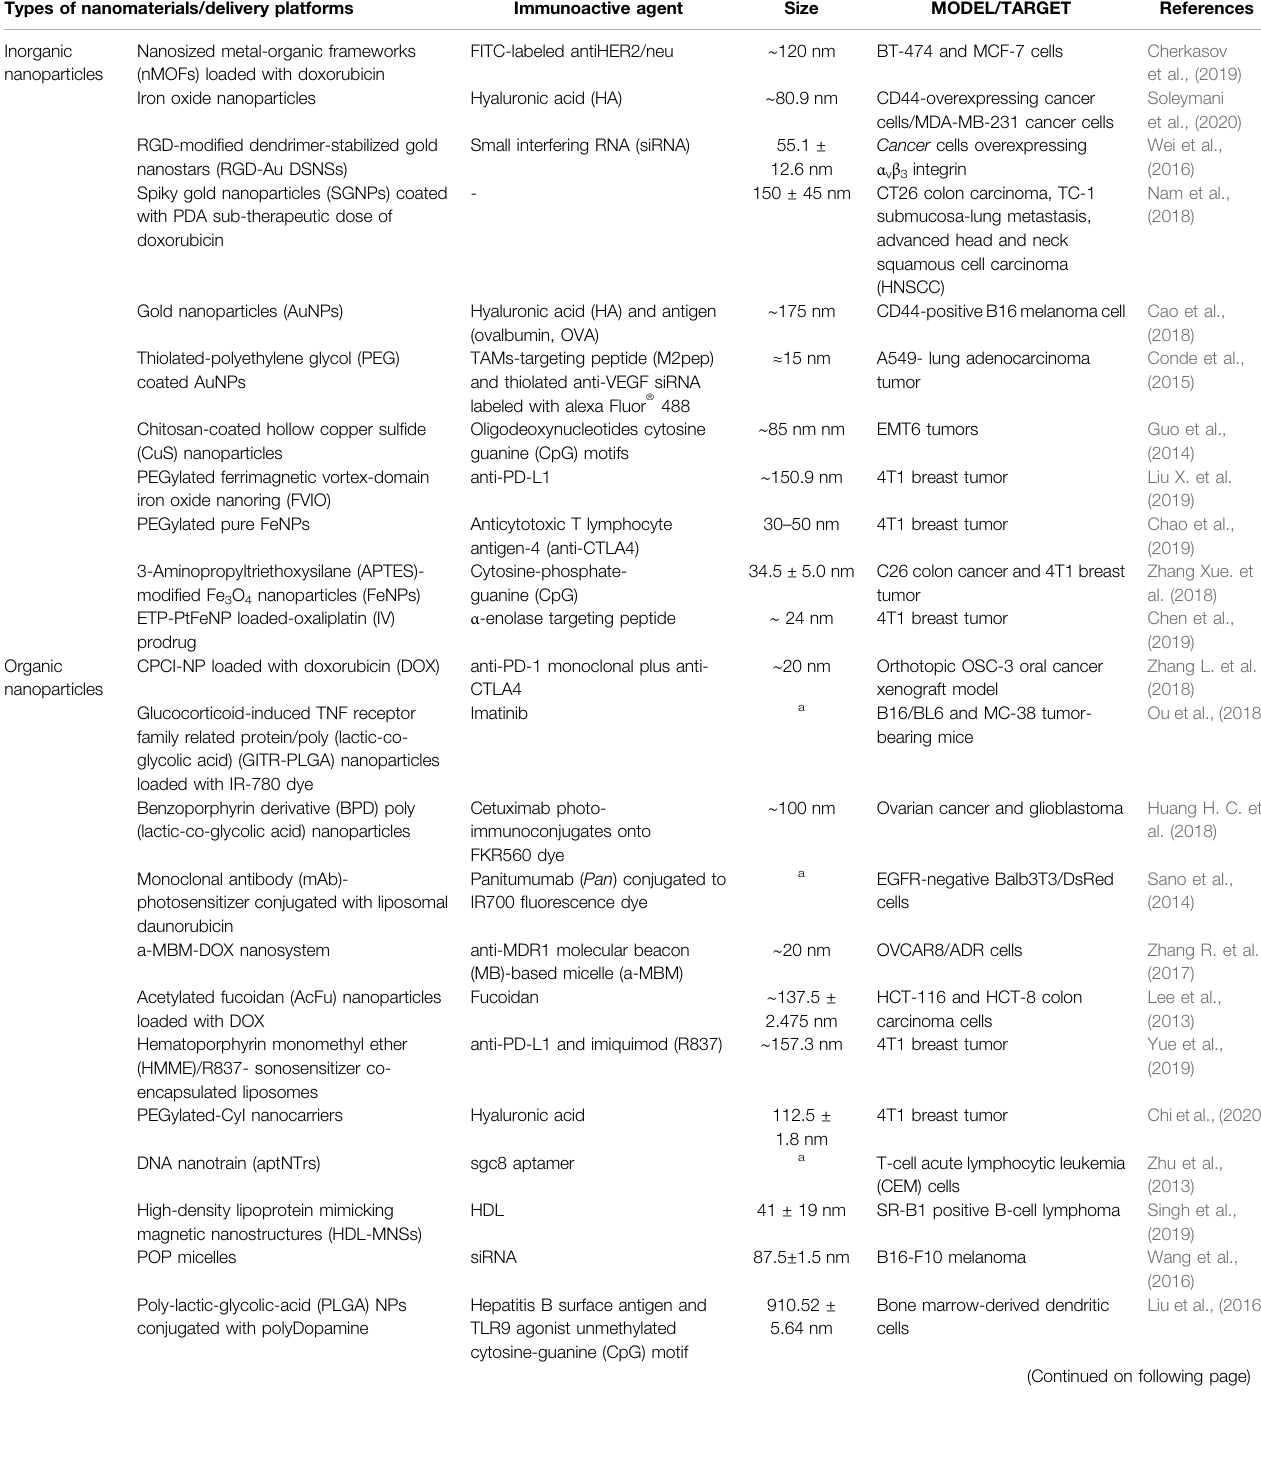
TABLE 1 | List of Theranostic nanomaterials for immunomodulation activity. Types of nanomaterials/delivery